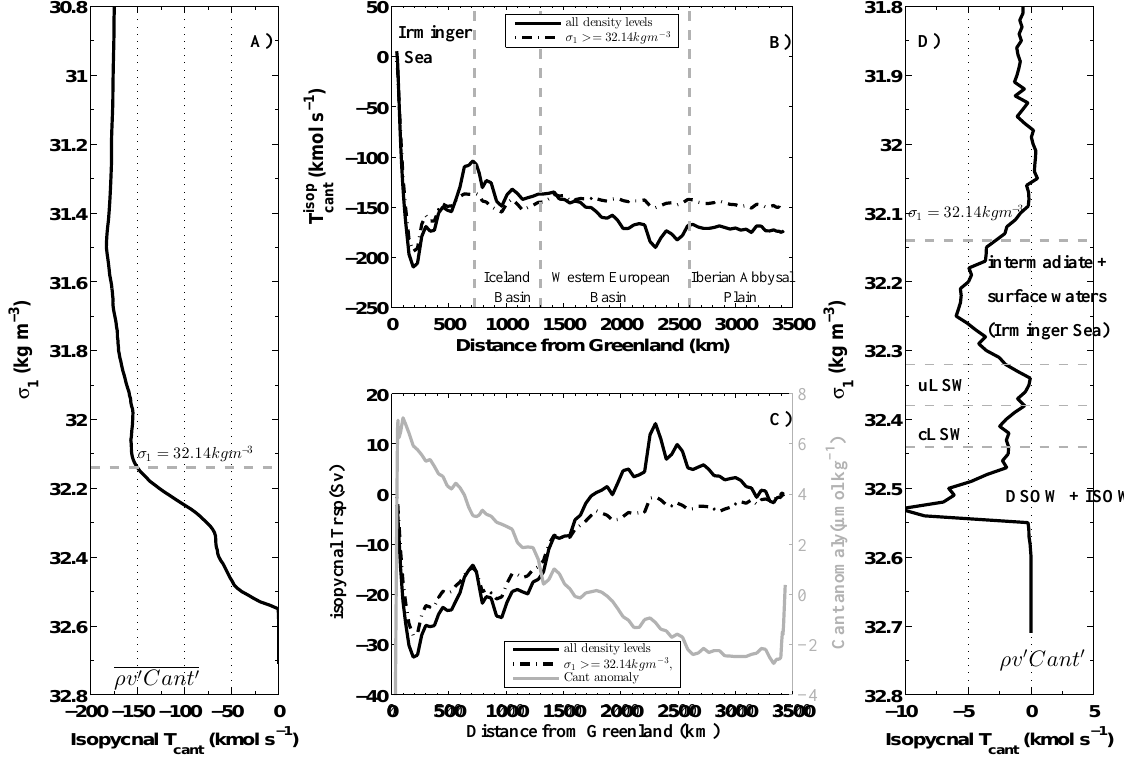
Fig. 4. Transport of Cant caused by the isopycnal component ( T isop cant ) averaged over time. (A) T isop cant accumulated from the bottom to each specific density level. (B) T isop cant horizontally accumulated from Greenland to each station along the section, and vertically integrated for the whole column of water (continuous lines) and for waters denser than 32.14kgm − 3 (dashed lines). (C) On the left axis: isopycnal volume transport accumulated from Greenland to each station, and vertically integrated for the whole column of water (continuous black line) and for waters denser than 32.14kgm − 3 (dashed black lines). On the right axis, in grey, mean value of Cant anomalies vertically averaged all along the section. (D) T isop cant horizontally but not vertically integrated (see Fig. 1 for the abbreviations). Note that in plots (A) and (D) , the vertical axes do not have the same